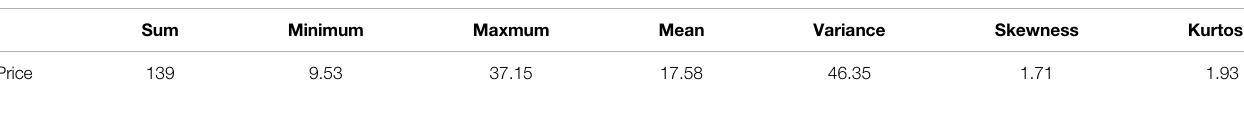
TABLE 1 | The descriptive statistics of hog ’ s prices based on time